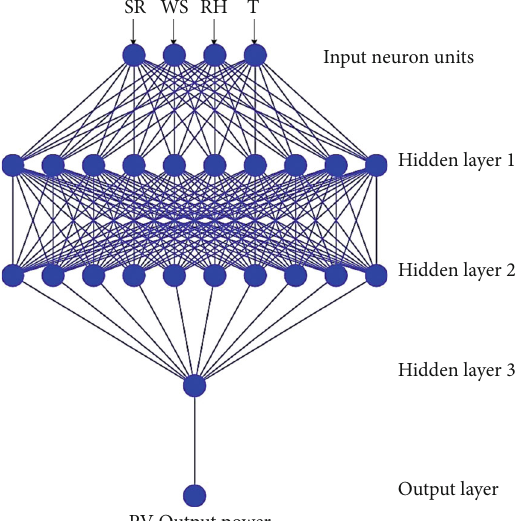
Figure 2: Neuron fl ow